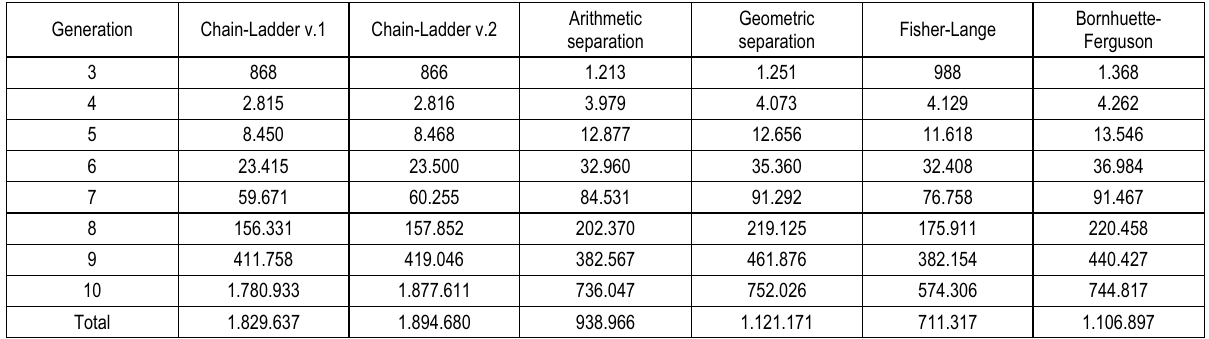
Table 4. Mean percentage error method of random development factors